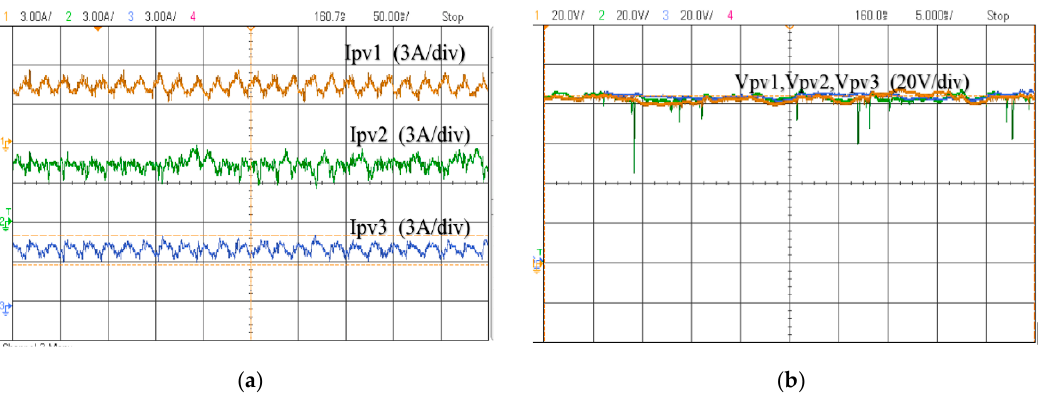
Figure 15. Experimental result for multi-input operation: ( a ) PV current, ( b ) PV voltage.